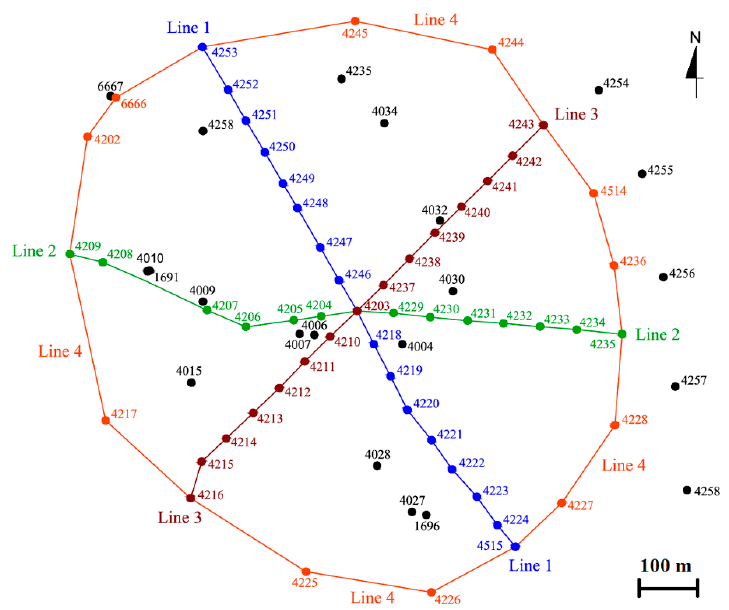
Figure 8. The distribution of the geodetic network over the DSD.